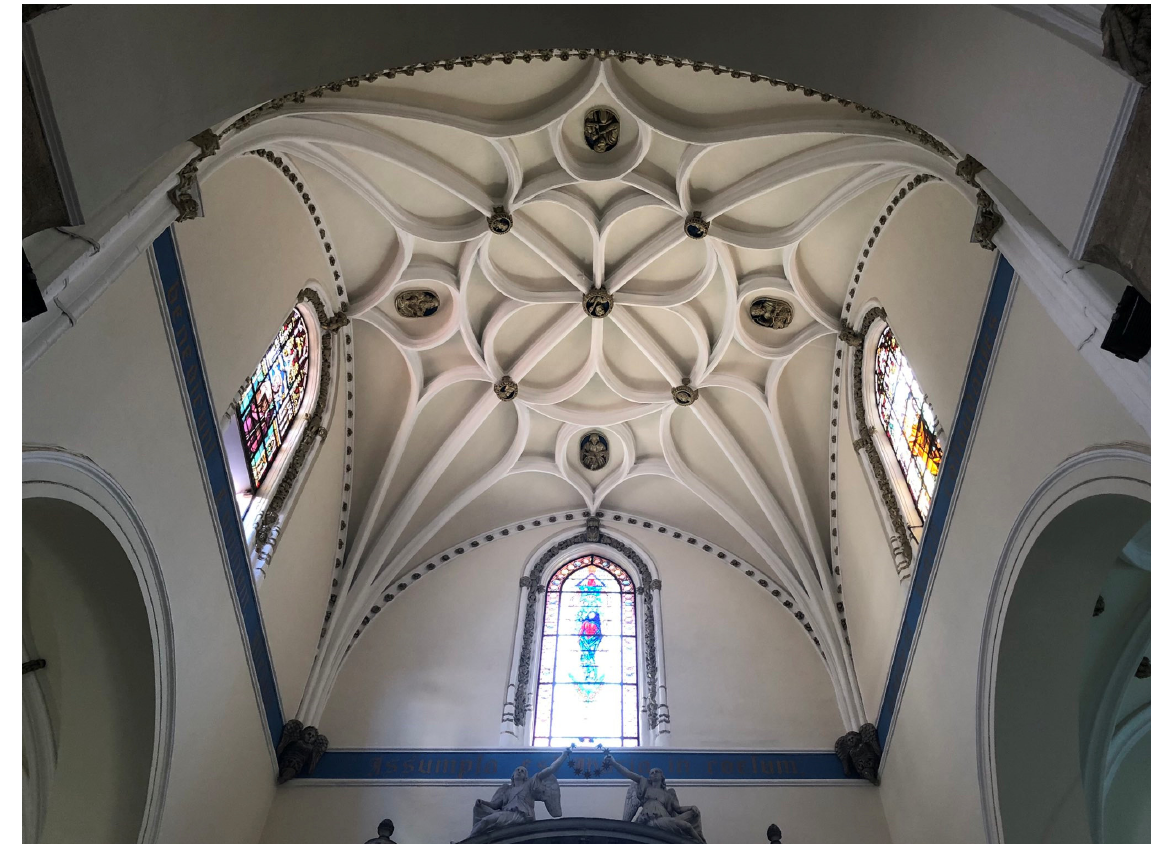
Figure 12. Gothic vaulting above the high altar of the Cathedral of Saint Mary the Crowned, Gibral- tar.